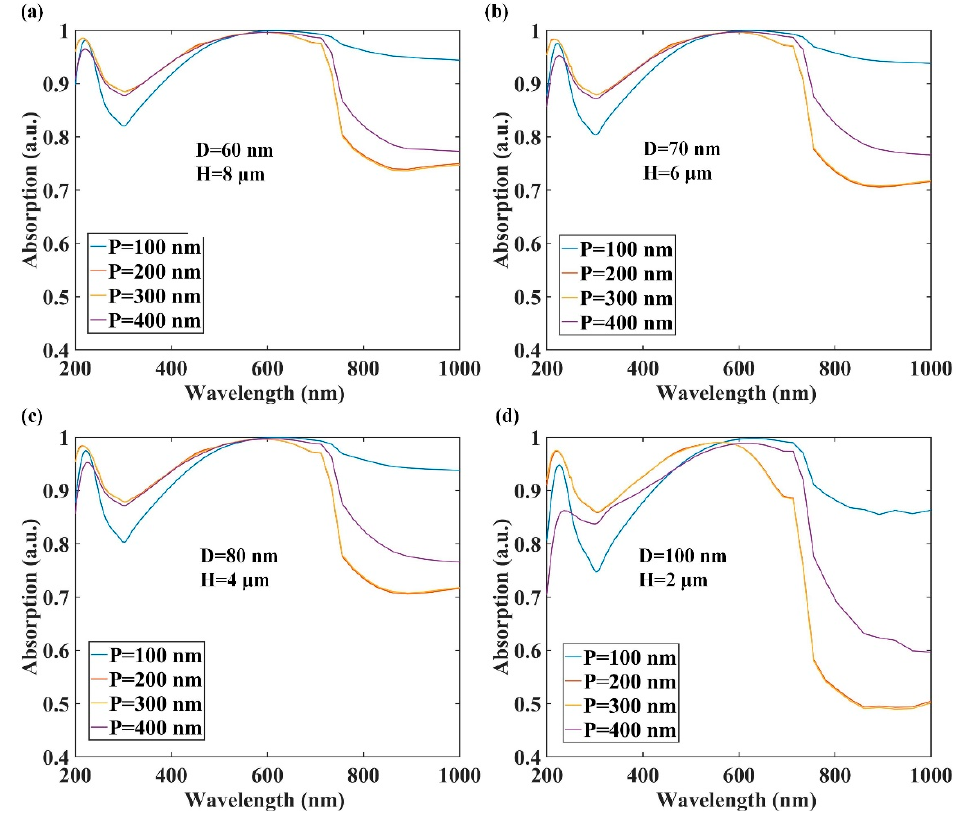
Figure 3. Light absorption enhancement in anodic aluminum oxide pores with embedded CdSe quantum dots and 100 nm, 200 nm, 300 nm, and 400 nm periodic spaces for ( a ) D = 60 nm and H = 8 μ m, ( b ) D = 70 nm and H = 6 μ m, ( c ) D = 80 nm and H = 4 μ m, and ( d ) D = 100 nm and H = 2 μ m.